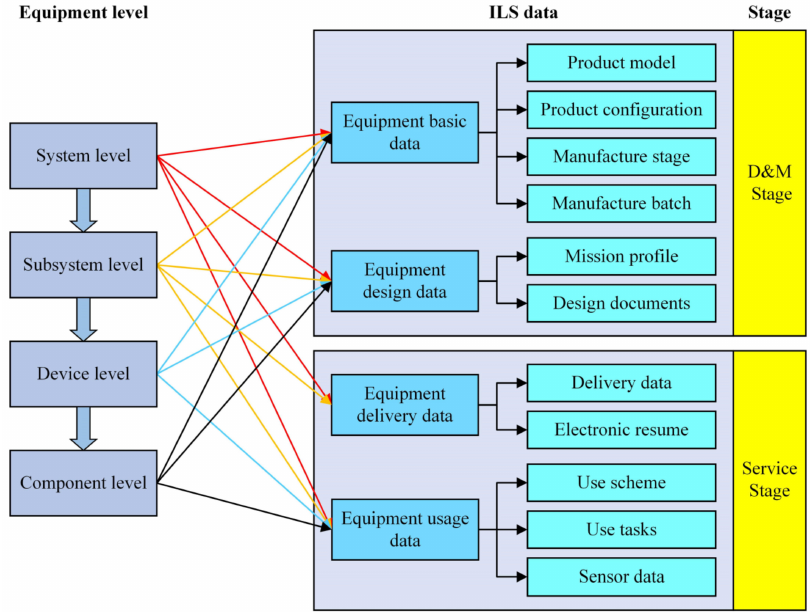
Figure 2. The relationships between equipment levels, stages, and ILS data.